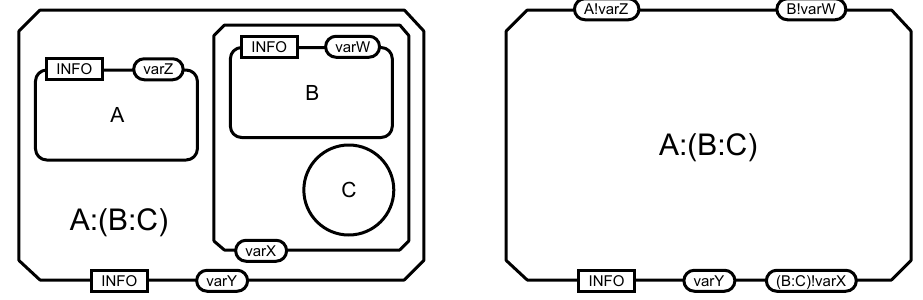
Figure 2.8: Both these complex glyphs are equivalent. The complex on the left is described using subunit decorators. The complex on the right depicts the same information, without explicitly representing those subunits, that are only suggested by the label of the complex . However, their states are represented using state variables decorating the complex .